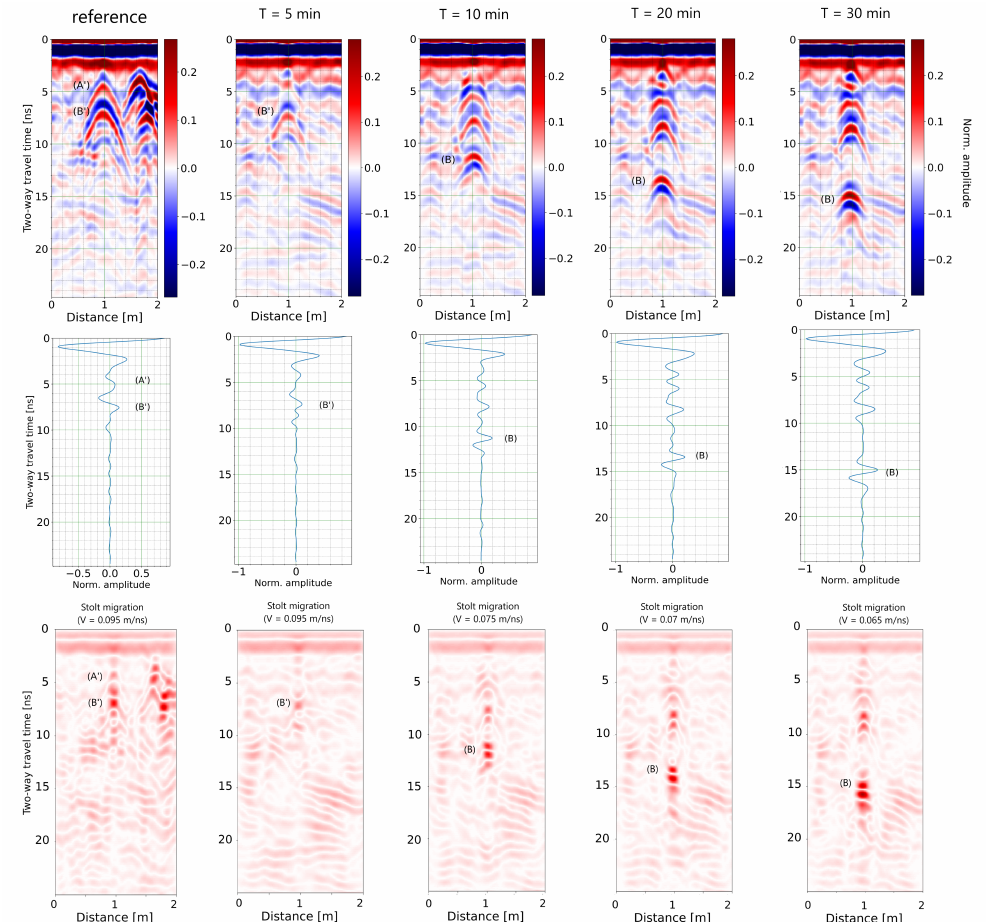
Figure 10. ( Top ): Radargram (no gain applied) acquired at 5, 10, 20, and 30 min after the start of the experiment. ( Middle ): Trace acquired right above the pipe. ( Bottom ): Migrated radargram using the velocity indicated just